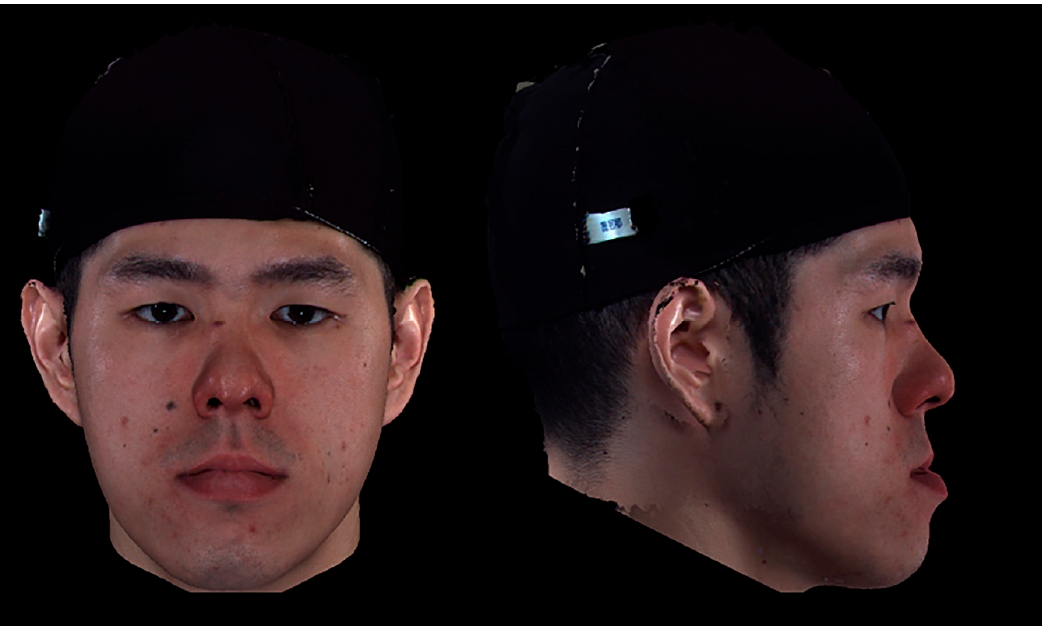
Figure 2. An example of a three − dimensional facial image of a male patient with a skeletal class III deformity pre − orthognathic surgery. On panel assessment, the average perceived facial personality traits were 3.6, 3.1, and 3.3 (lay observer, orthodontic professional, and surgical professional, respectively); 3.4, 3.7, and 3.2; 3.8, 4.1, and 3.9; 3.4, 3.3, and 3.8; and 3.1, 3.7, and 3.5 for the intelligent, friendly, threatening, trustworthy, and dominant parameters, respectively.